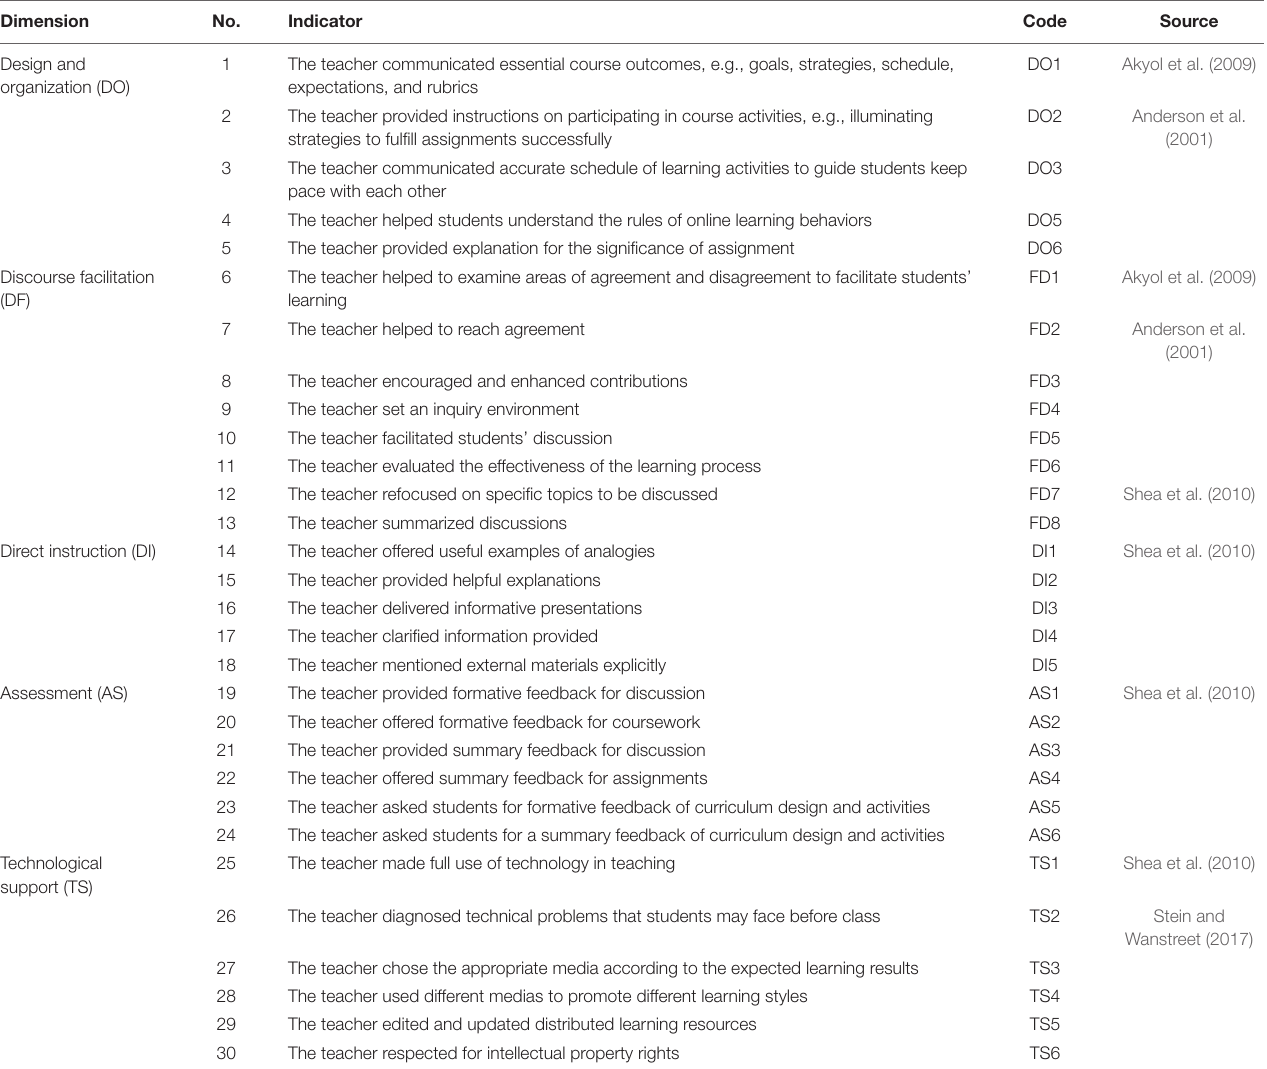
TABLE 1 | Items of the five-dimensional teaching presence scale. Dimension No. Indicator Code